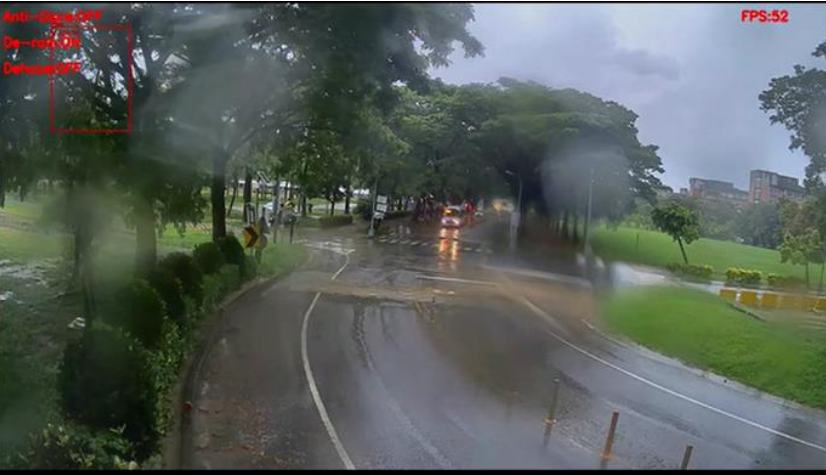
Figure 30. Rainy scene image frame detected by YOLOv3.